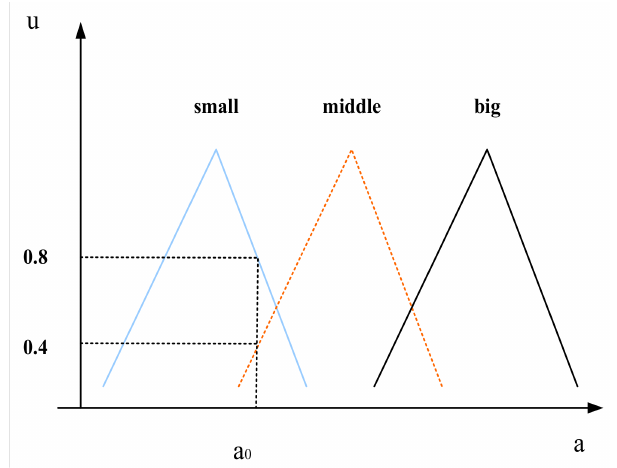
Figure 2. Typical fuzzy set.